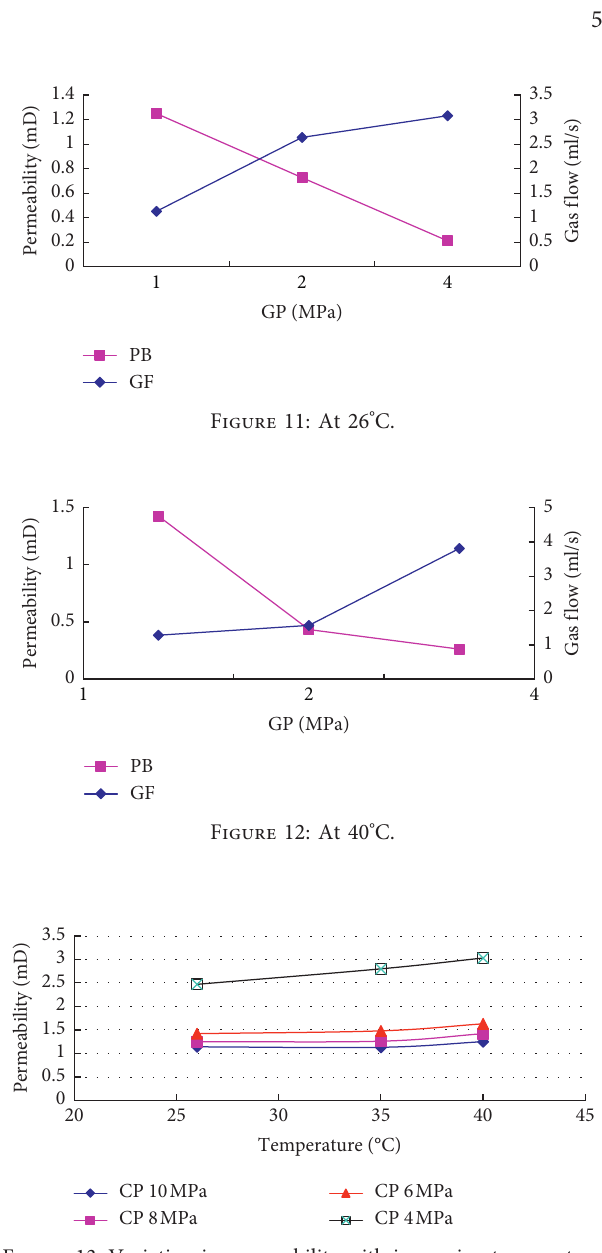
Figure 13: Variation in permeability with increasing temperature at a gas pressure of 1MPa.